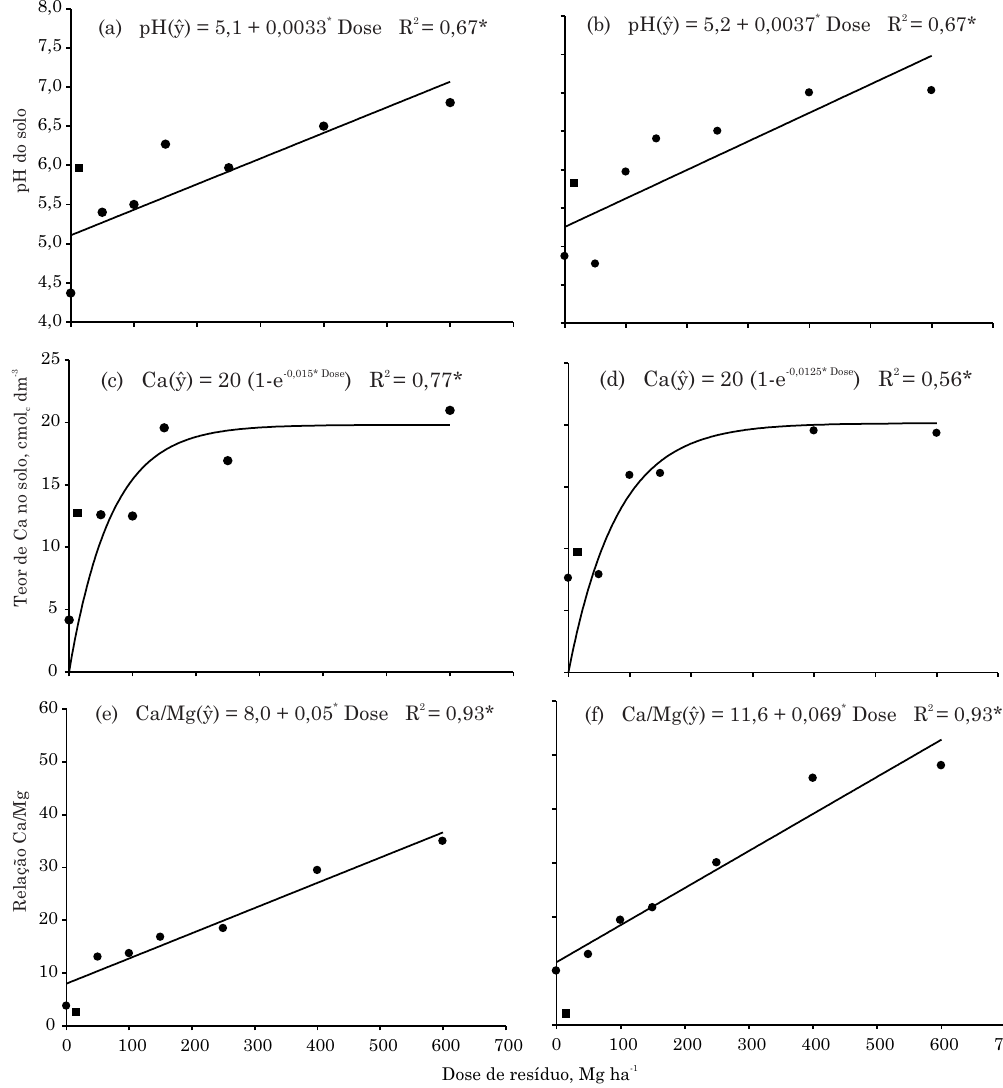
Figura 1. pH do solo determinado em água (a, b), teores de Ca no solo (c, d) e relação Ca/Mg (e, f) em função de doses de resíduo de reciclagem de papel ( lllll ) e com aplicação de calcário ( nnnnn ) (amostragens: abril de 2010, na esquerda, e abril de 2011, na direita). * Significativo a 5 % pelo teste